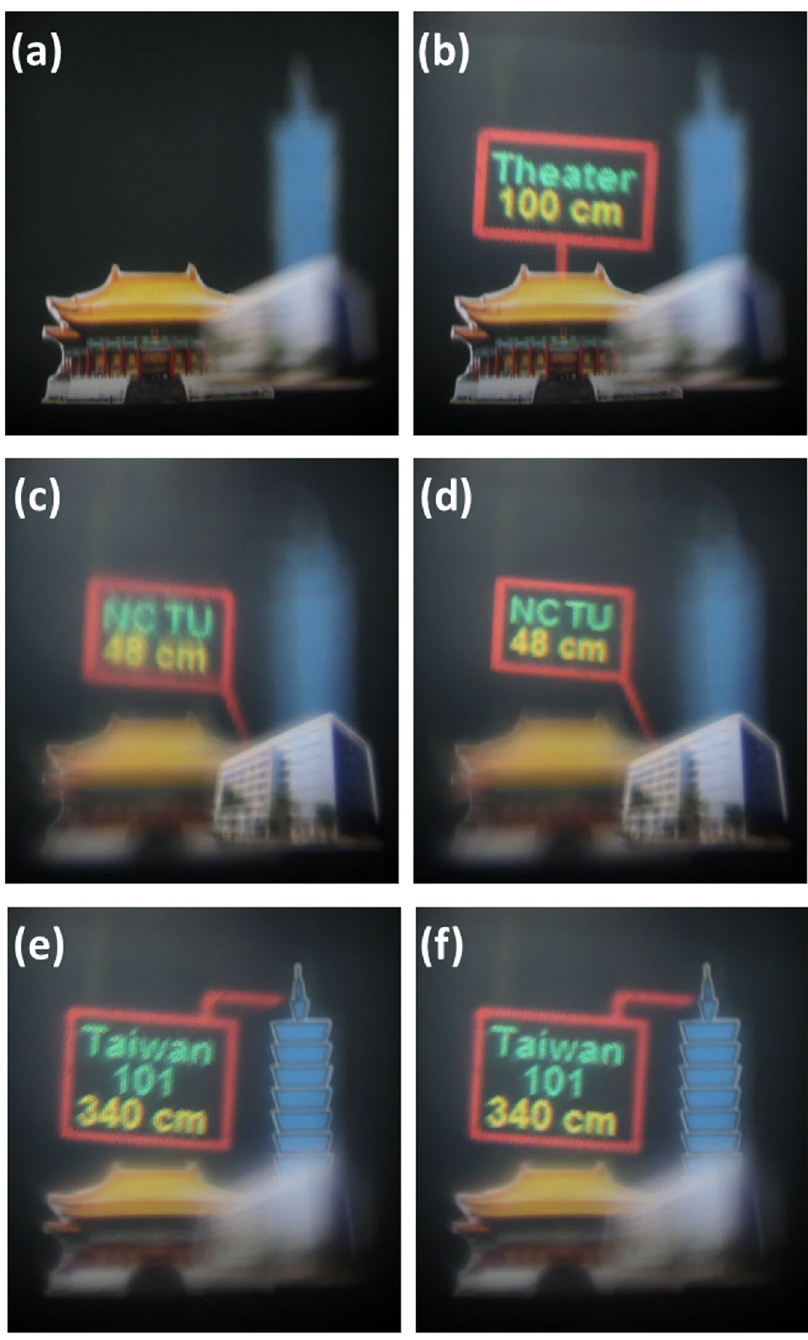
Figure 7. Images of proposed AR system with vision correction and registration function. Three printed objects: “Taiwan 101 building”, a “theater”, “NCTU building” were placed at the distance of 340 cm, 100 cm, 48 cm in front of “LC lens 2”. ( a )The camera was set to see the object at 100 cm in focus when two LC lenses and LCoS panel were off. ( b ) The virtual image was aligned with theater when we turned on LCoS panel with input of a text and added lens power of − 0.25 D of “LC lens 1”. ( c ) from ( b ), to correct presbyopia, lens power of 1.01 D of “LC lens 2” was added. But the virtual image at 100 cm was blurred. ( d ) From( c ), change the lens power of “LC lens 1” to − 0.94 D. Both of NCTU building and the virtual image were clear.( e ) from ( b ), to correct Myopia, lens power of − 0.67 D of “LC lens 2” was added. But the virtual image at 100 cm was still blurred. ( f ) from ( e ), change the lens power of “LC lens 1” to − 0.10 D. Both of Taiwan 101 building and the virtual image were clear. The movie file is in ref. 25. The “ NCTU building” is imaged by Pi Cheng Wu and the copyright is released to the authors and Nature Publishing Group. The “Theater” is photographed by Fred Hsu and distributed under license of CC BY-SA 3.0 (https://creativecommons.org/licenses/by-sa/3.0/) on https://en.wikipedia.org/wiki/